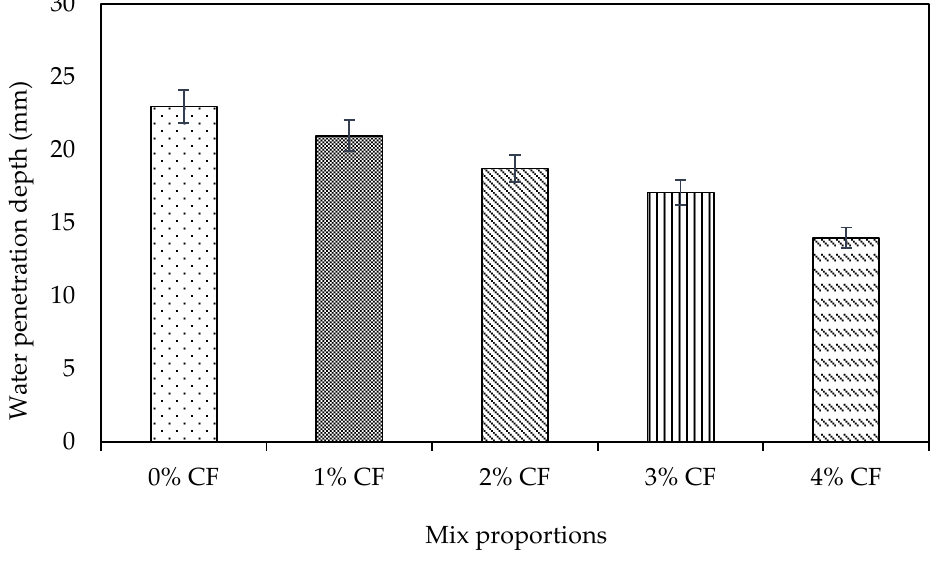
Figure 11. Permeability (water penetration depth) of coir fiber-reinforced concrete. Table 10. Descriptive statistical analysis of concrete subjected to permeability.